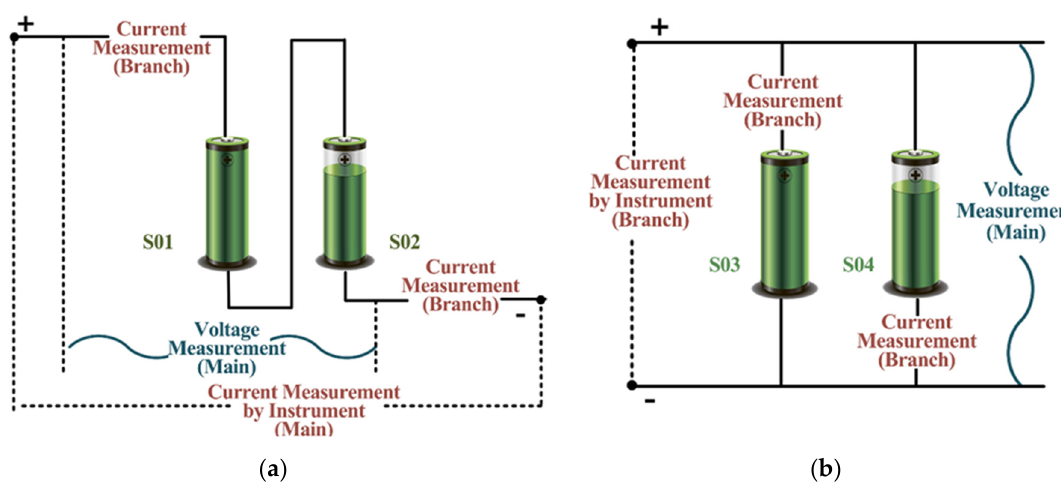
Figure 12. Two-cell pack measurement schematic diagram: ( a ) series; ( b ) parallel.